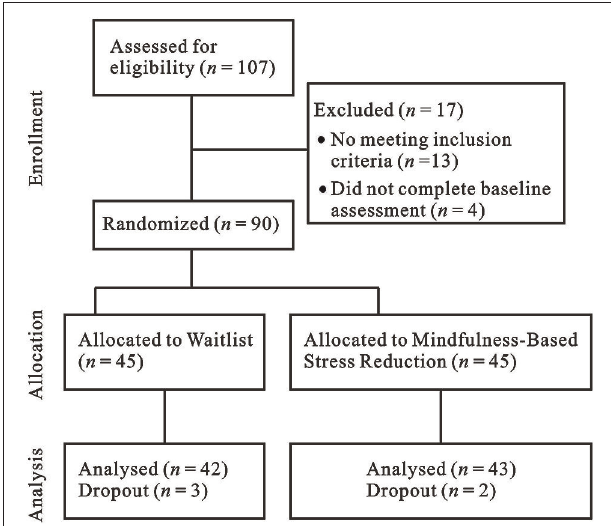
FIGURE 1 | Flowchart of study